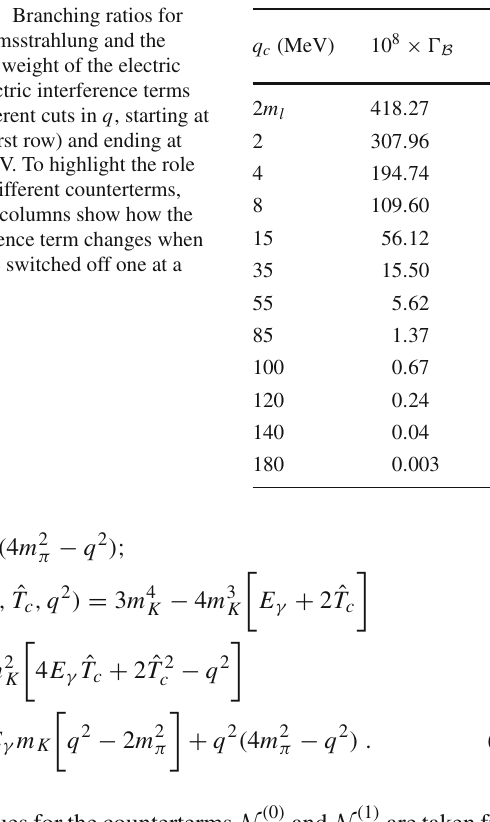
Fig. 1 Dalitzplotsfortheinterferencedifferentialdecayrateof K + → π + π 0 e + e − in the ( E γ , T ) plane for q = 20 MeV (left panel) and c q = 50 MeV (right panel). Numbers are given in units of 10 − 20 GeV − 1 .